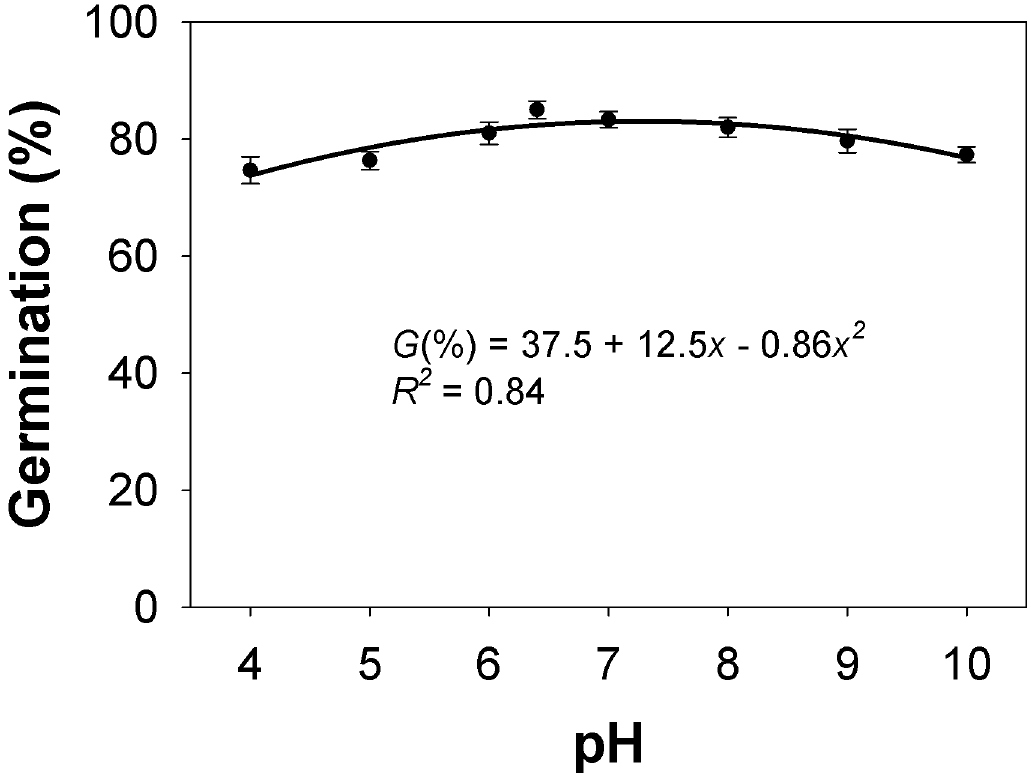
Fig 4. Effect of pH on seed germination of Chloristruncata after 21 d of incubation at 25/15˚C day/night temperature. The line represents a quadratic model fitted to the data. Vertical bars represent standard error of mean.